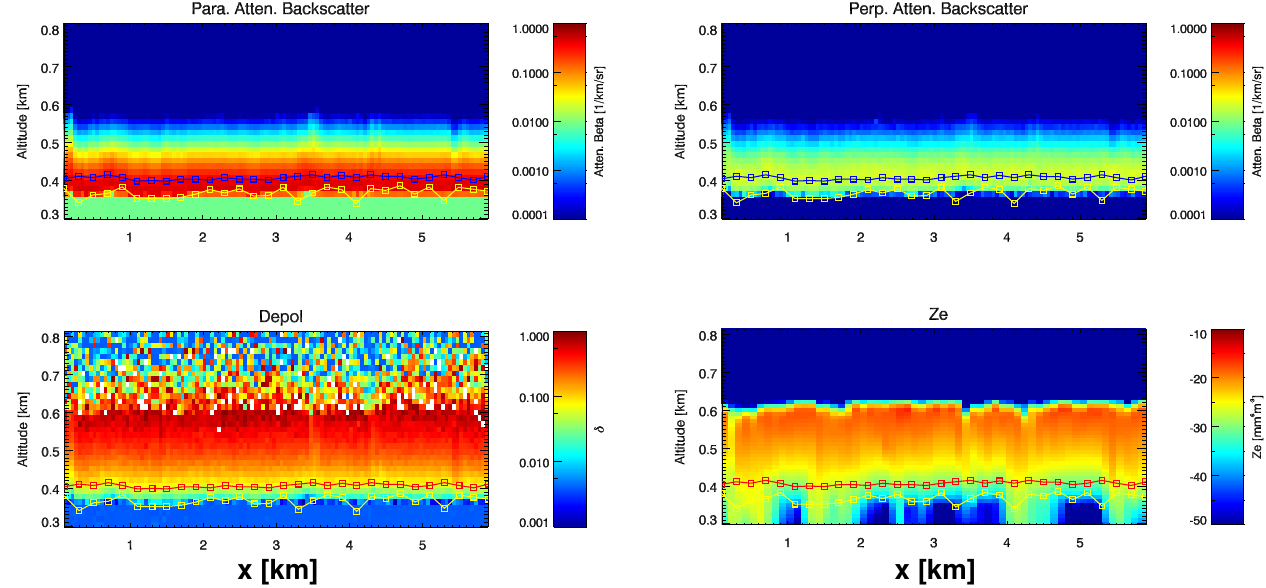
Figure 9. Simulated parallel and perpendicular attenuated backscatter signals for a 355nm depolarisation lidar with a FOV of 1mrad. Also shown are the corresponding linear depolarisation ratio and the radar reflectivity ( Z e